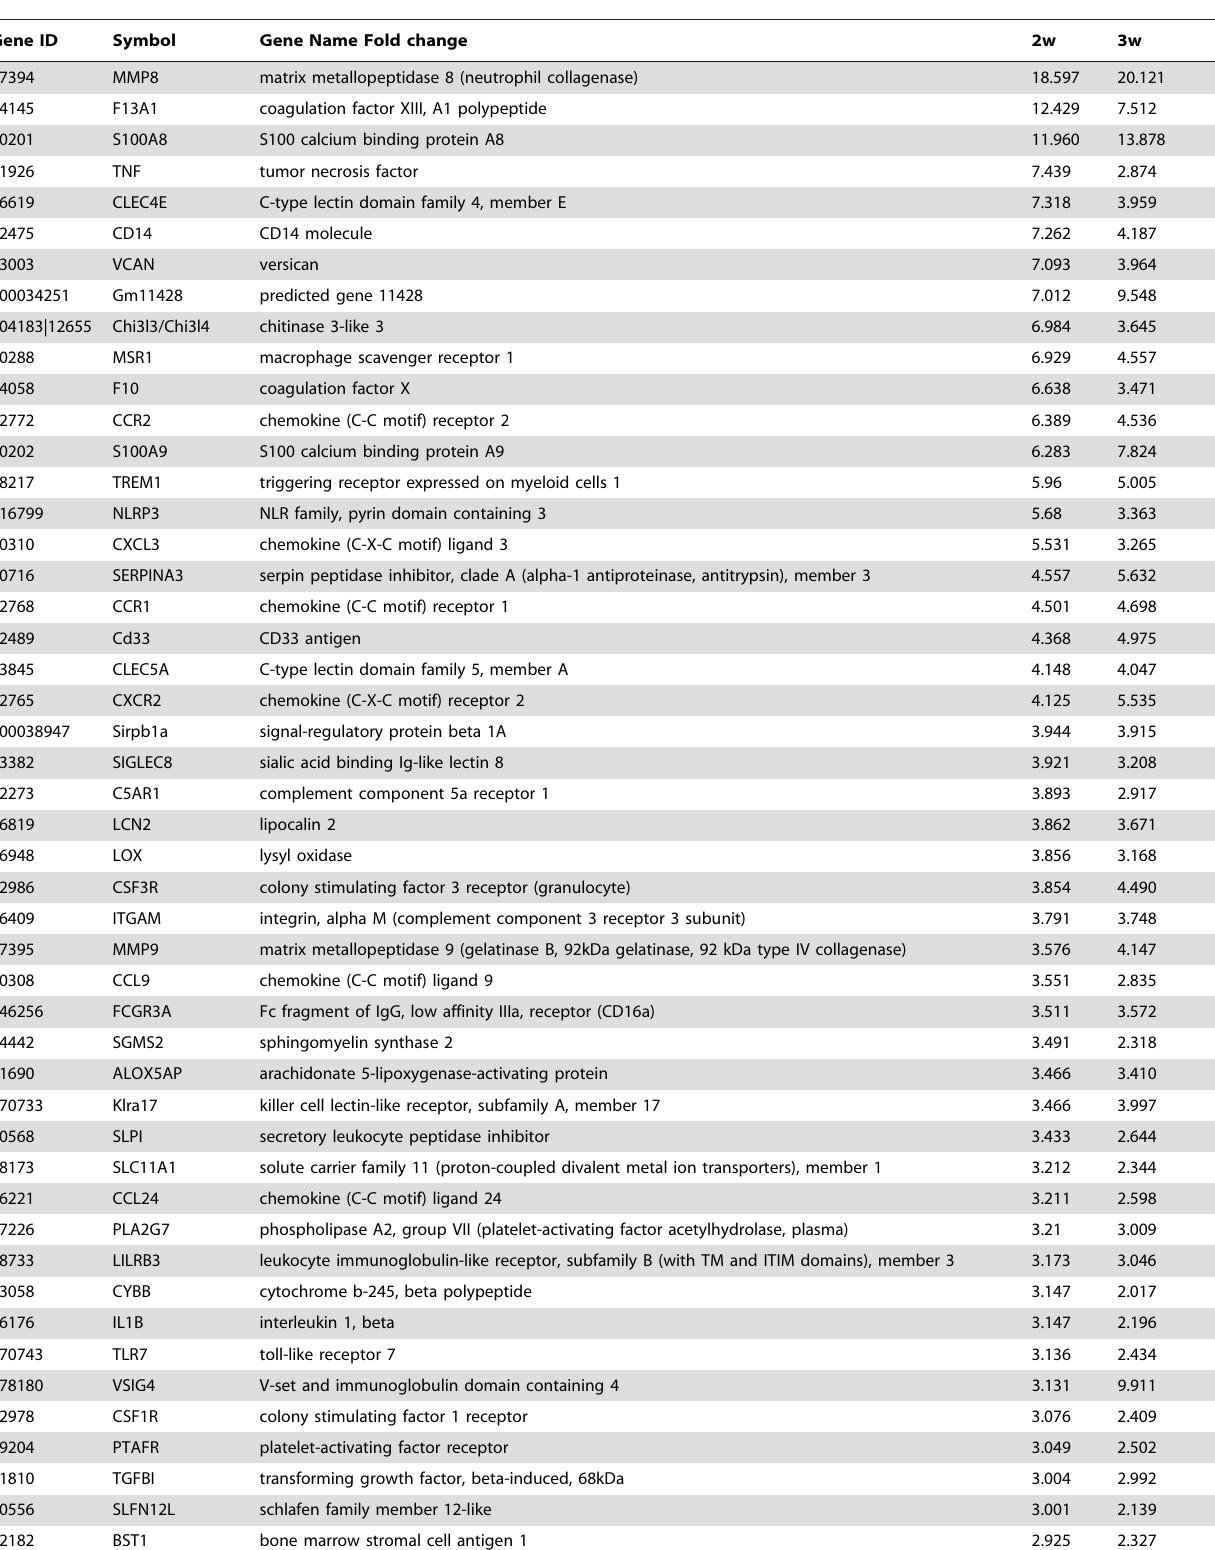
Table 3. Genes up- or down-regulated . 2.0 fold in pulmonary cells of mice at 2 and 3 weeks after CBDL, assembled by a magnetic bead/CD31-antibody complex, in comparison with levels in sham operated mice, as determined by the Gene Chip Mouse Gene 1.0 ST